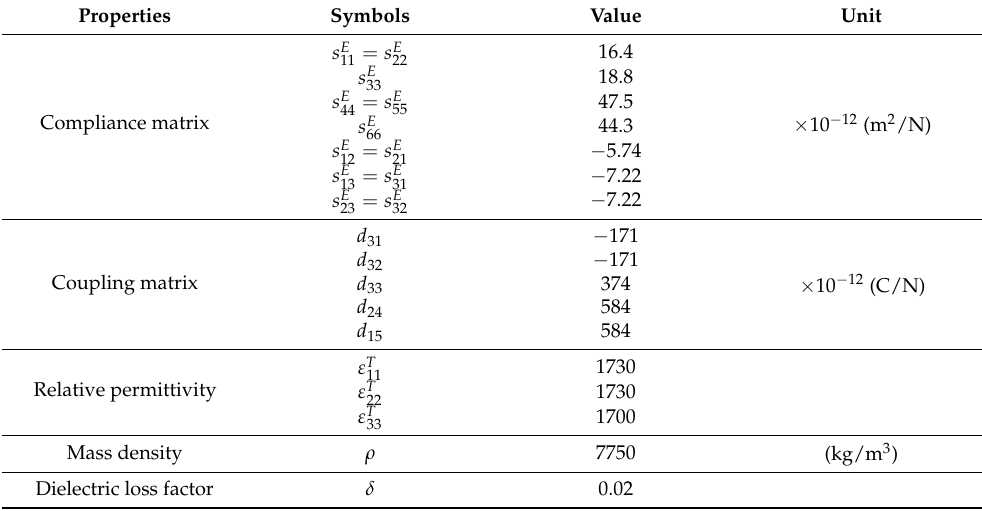
Table 3. Piezoelectric properties of the transducer [7].